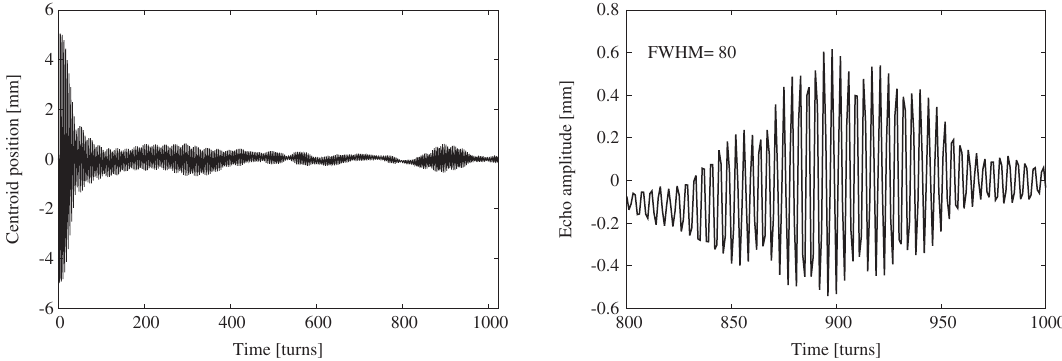
FIG. 6. The entire centroid position turn by turn (left) and the echo pulse isolated (right) for the data with the largest FWHM. Notice the much larger and longer ringing of the centroid after the dipole kick. The quadrupole kick was applied again at turn 450.